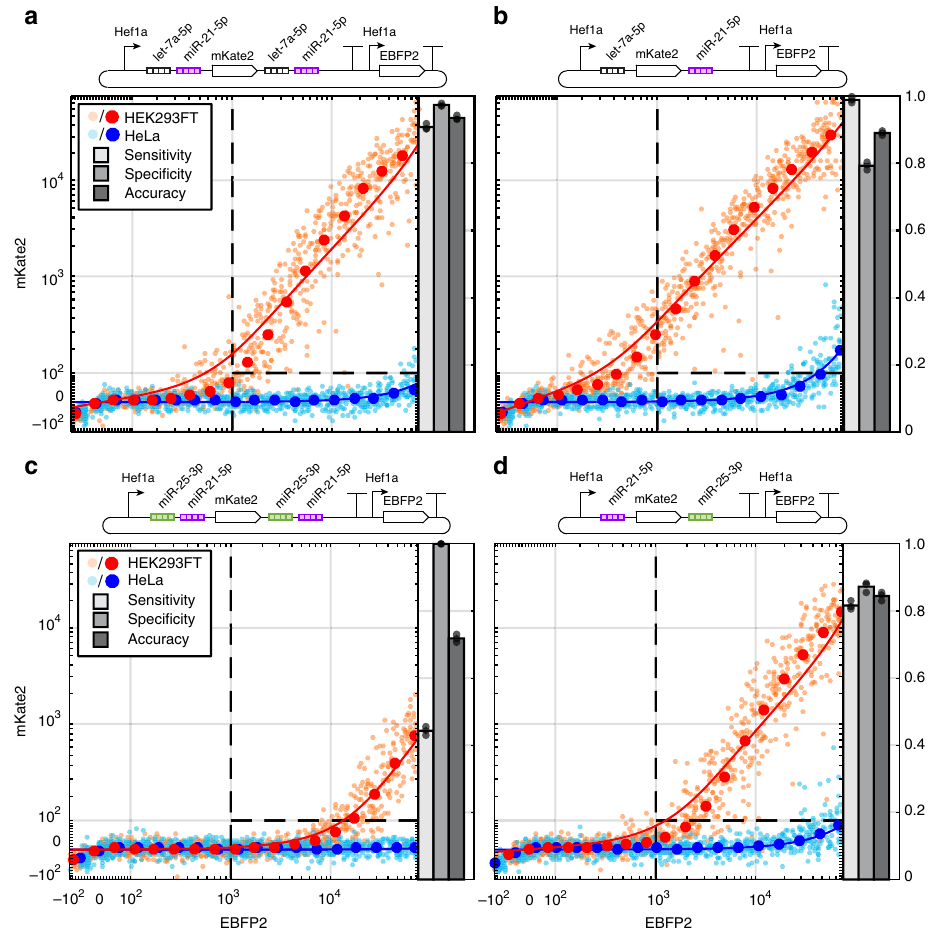
Fig. 7 Ant/Syn model predicts the effects of target site position and number on the trade-off between sensitivity and speci fi city. Several classi fi ers were tested to further explore the effect of target set position and duplication on classi fi er sensitivity, speci fi city, and accuracy. We chose to sense three different miRNAs: miR-21-5p and let-7a-5p have high activity in HeLa and slight activity in HEK293FT, miR-25-3p has medium activity in HeLa and HEK293FT. In this example, miR-25-3p would be important for classifying against a third cell type not shown here (e.g., glioma 47 ). a , b To test the effects of miRNA target set duplication on classi fi cation, versions of 2-input classi fi ers were built containing two target sets for let-7a-5p and miR-21-5p in both UTRs ( a ), or single sets in separate UTRs ( b ). Output in the classi fi er with four total target sets was dominated by synergy between miR-21-5p activity from both UTRs, resulting in very low output in HeLa and high speci fi city (97%) but with a slight trade-off in sensitivity (91%) since output in HEK293FT (where miR-21-5p activity is greater than let-7a-5p) was reduced with target site duplication. In contrast, high sensitivity (99%) but lower speci fi city (79%) was obtained with the classi fi er with only a single set of each miRNA target ( b ) since output in HEK293FT cells was attenuated by only one miR-21-5p target set. c , d Classi fi ers similar to a and b were built containing sets of target sites for miR-21-5p and miR-25-3p with duplication ( c ) and without ( d ). Again duplication resulted in high speci fi city (100%) but with a signi fi cant trade-off in sensitivity (44%) due to synergistic effects from both sets of miR-25-3p targets, which allows two medium activity target sets to exhibit high activity when combined in HEK293FT cells. Also, miR-25-3p targets contain an ATG sequence uORFs. These effects result in greatly improved sensitivity (82%) at a cost of slightly reduced speci fi city (87%). The latter classi fi er also showed higher overall accuracy (84% compared to